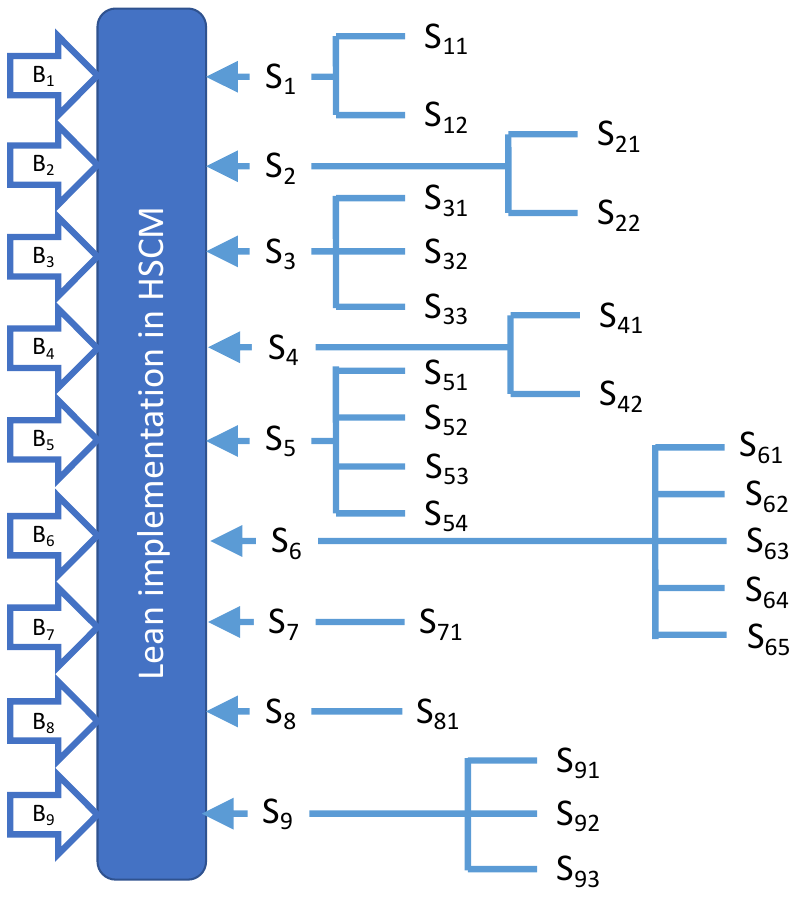
Figure 3. Force field analysis. Table 3. Suggested Solutions to overcome Barrier.